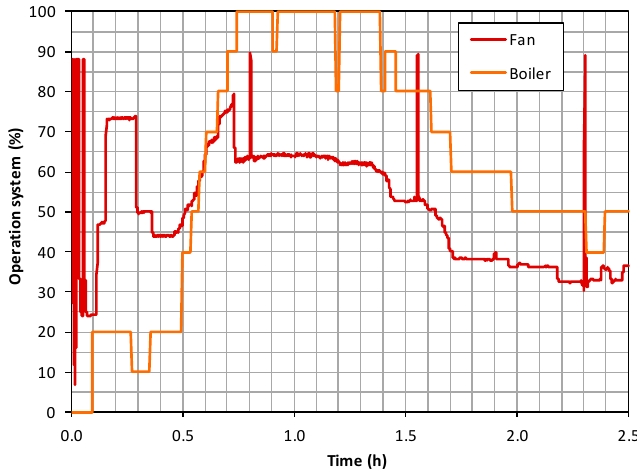
Figure 5. Boiler modulation during the combustion test of COM pellets.